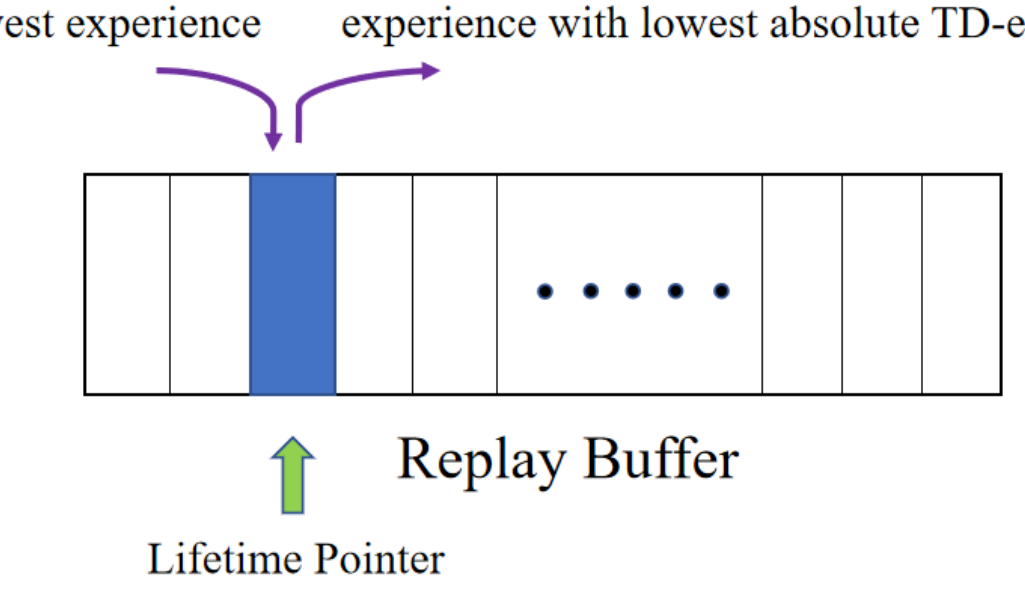
Figure 1. Replay buffer with lifetime pointer.